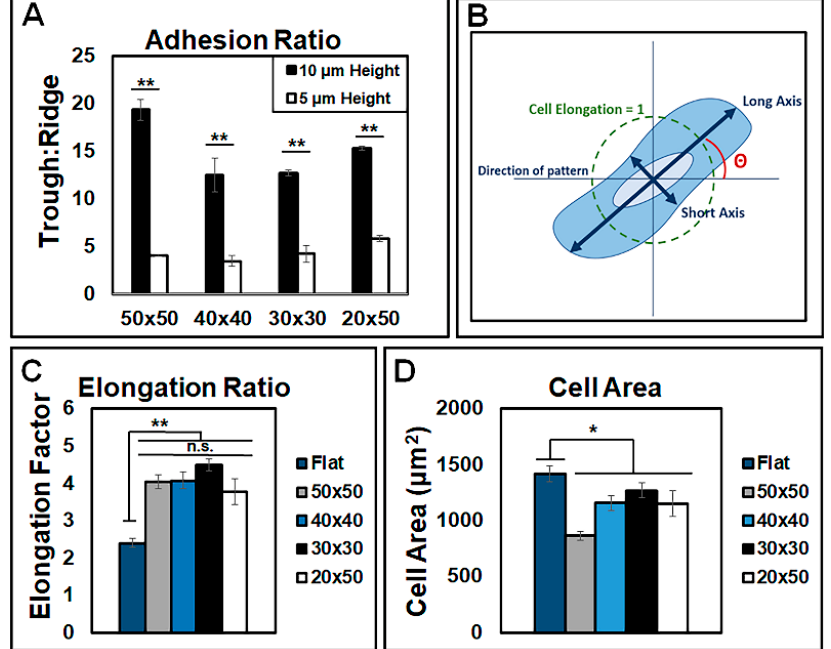
Figure 2. Cell morphology was controlled by micropatterned PDMS surfaces. ( A ) Cell adhesion as ratios of the micropatterning trough and ridge dimensions, for the cells present in the images, for both 10 and 5 μ m heights; n = 3 substrates per condition and five images per substrate. ( B ) Visual representation of the quantification method for defining the long and short axis dimensions. ( C ) Cell elongation ratio on micropatterned substrates and ( D ) total area of individual cells cultured on 10 µ m-height patterns. n = 4 unique images per condition, with at least 20 cell measurements per image. Data are presented as mean ± SE, where * p ≤ 0.05, ** p ≤